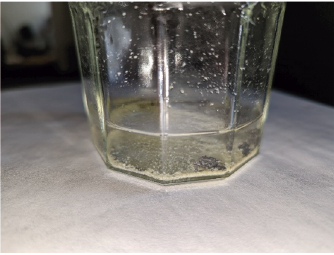
Figure 2. White precipitate obtained from the bubbling of CO